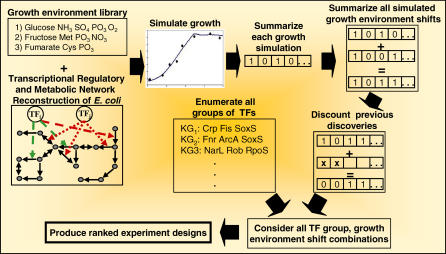
A Graphical Depiction of the Computational AlgorithmThe algorithm ultimately produces experiment designs ranked by their potential for producing the most new regulatory rules.TFi, transcription factor i ; TFj, transcription factor j.